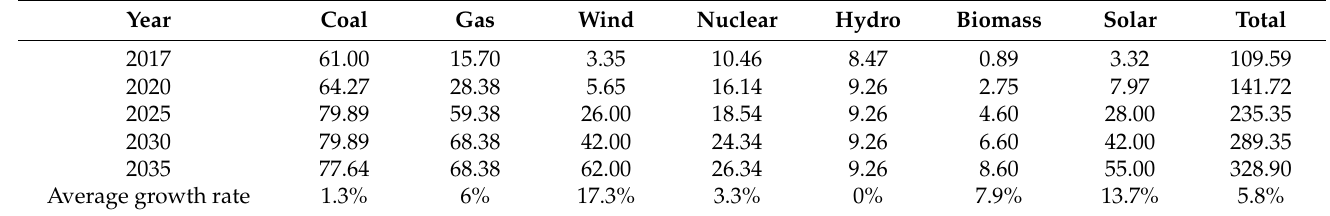
Table 3. Power installed capacity of various energy types in the Guangdong Province from 2017 to 2035